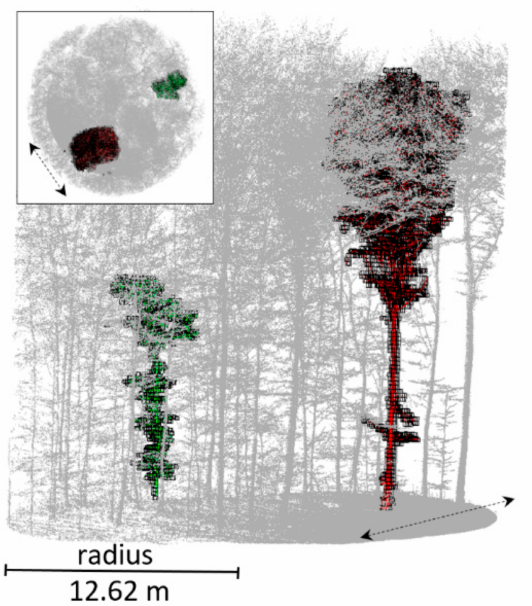
Figure 6. MLS leaf-off point cloud of plot 1 with voxel tree templates extracted with the TLS leaf-off point cloud of a Carpinus betulus tree ( green ) and a Fagus sylvatica tree ( red ). Small box: top view. The dotted black line with arrows indicates the MLS